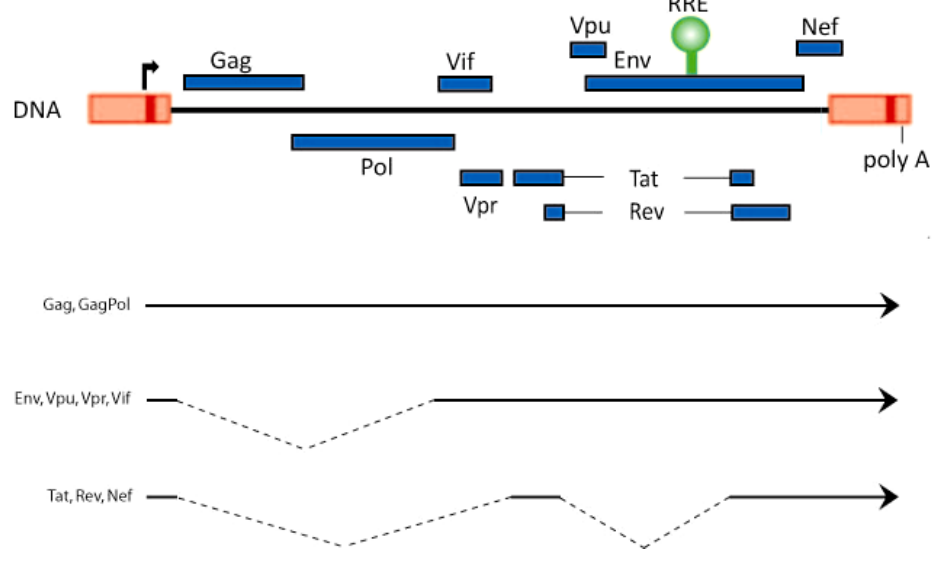
Figure 1. Schematic representation of the HIV-1 genome and its unspliced and spliced RNAs. The open reading frames and the position of the Rev-responsive element (RRE; green) are shown on top. The bottom lines represent the 9 kb unspliced, the 4 kb singly spliced, and the 1.8 kb doubly spliced HIV-1